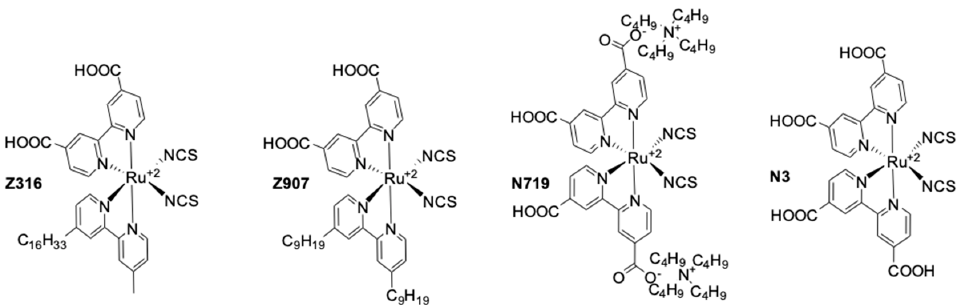
Figure 5. Ruthenium based dyes used in dye-sensitized solar cells (DSSCs).